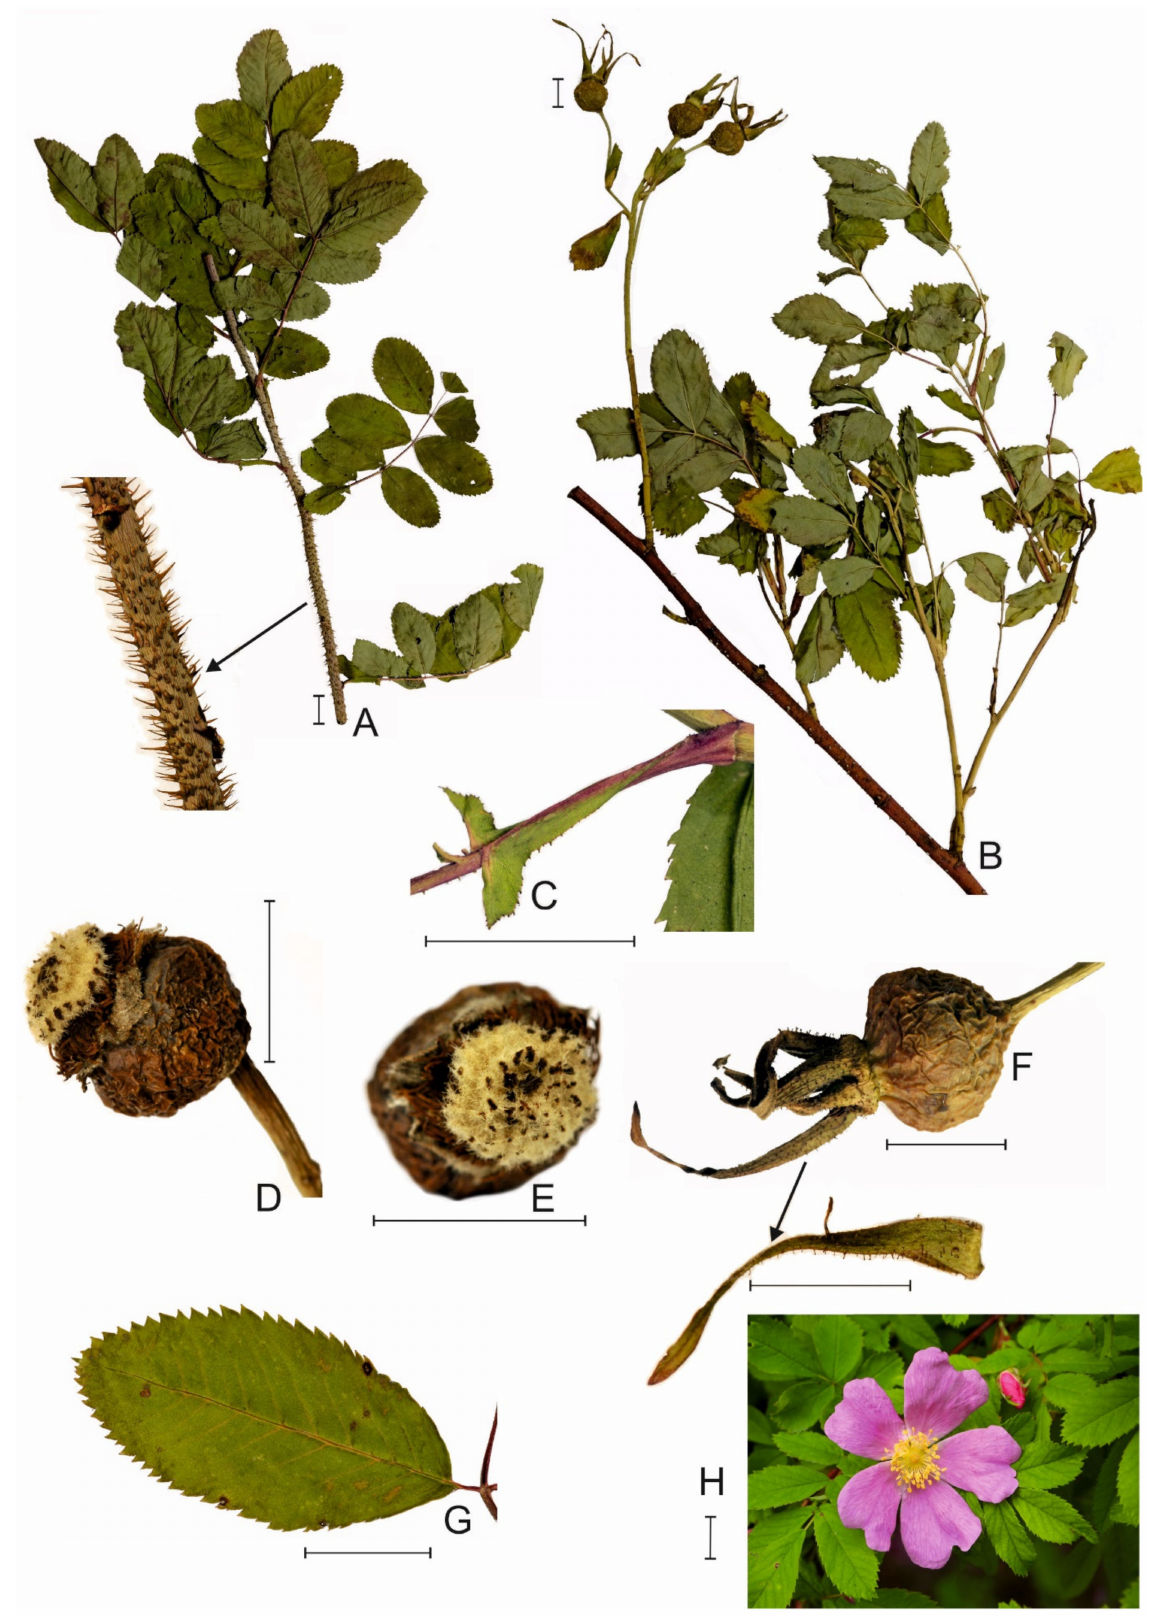
Figure 1. Characteristic features of Rosa blanda Aiton; ( A )—part of long shoot, ( B )—part of fruiting short shoot, ( C )—stipule, ( D , E )—fruit, ( F )—fruit with glandular sepal, ( G )—leaflet, ( H )—flower; solid bar = 1 cm (Photo Anna Sołtys-Lelek; specimen from Poland, collected by Wojciech Gruszka between Strzelce Kraje´nskie and Wielisławice,